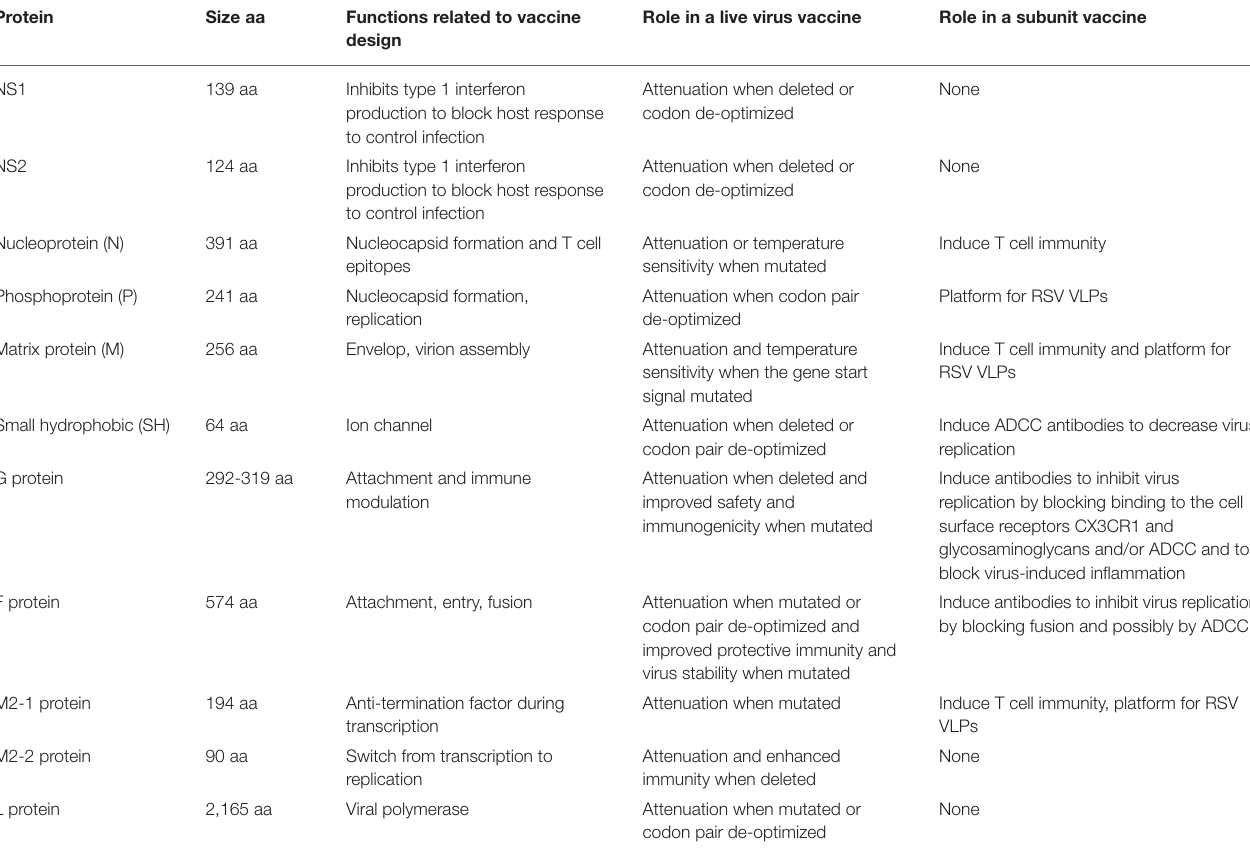
TABLE 1 | RSV proteins in live attenuated or subunit vaccines.